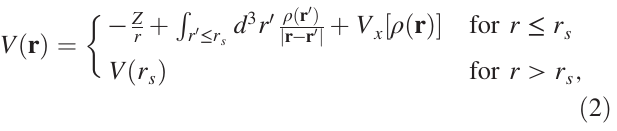
FIG. 1. Schematic diagram of an atomic model in a solid or a plasma. The purple dotted curve is the isolated atomic potential, the green dashed curve is the crystalline potential, and the black thick curve is the muffin-tin-type potential. The muffin-tin flat potential is denoted as ε s and the Wigner-Seitz radius is r s